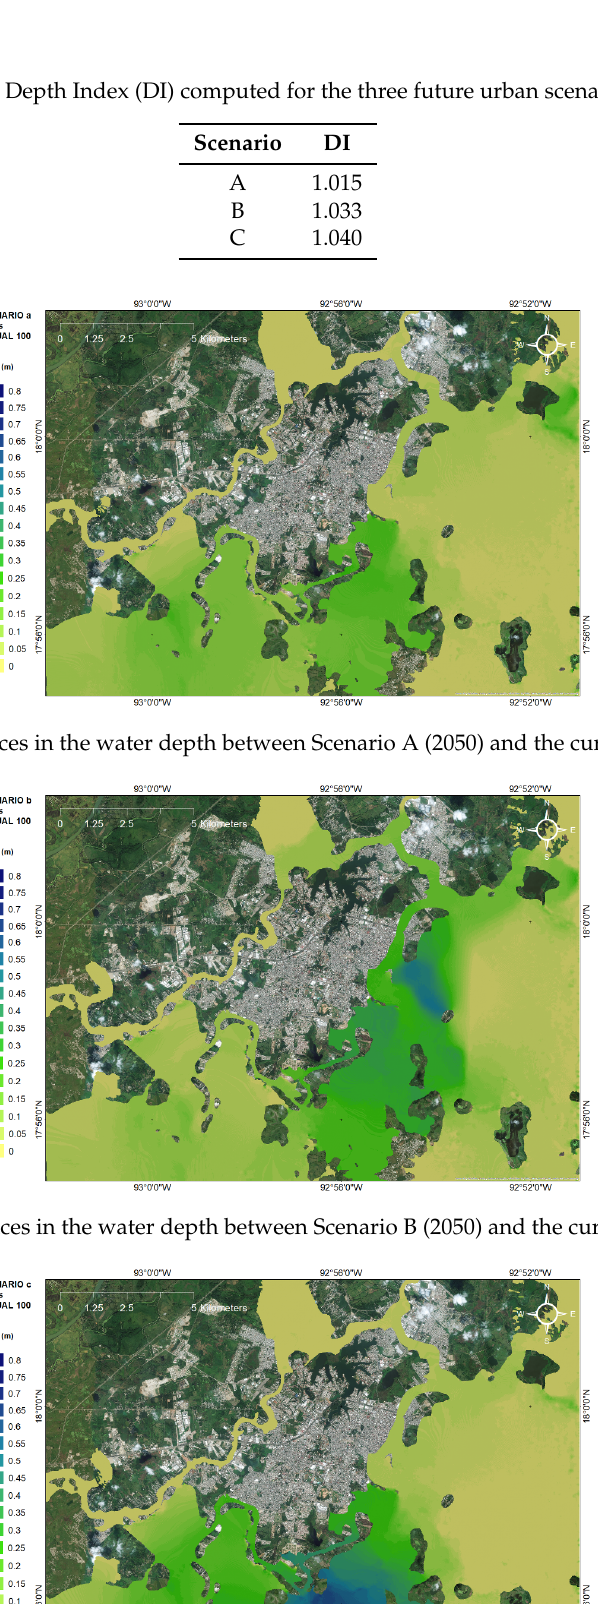
Figure 10. Differences in the water depth between Scenario C (2050) and the current